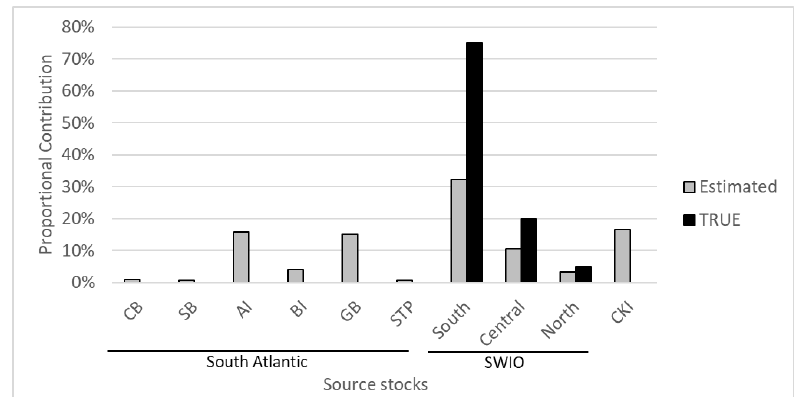
Figure A9. Simulated MSA. Graphs showing the proportional contributions estimated by BAYES (gray) from ten genetic stocks across the south Atlantic (Central Brazil, CB; South Brazil, SB; Ascension Is, AI; Bioko, BI; Sao Tome and Principe, STP), Southwest Indian Ocean (South; Central; North), and Cocos (Keeling) Islands, CKI to a hypothesized foraging aggregation. The simulated “true” value (black) of the composition represents 75% from the South, 20% from the Central, and 5% from the North Areas of the SWIO, with no contribution from Atlantic stocks and Cocos (Keeling)